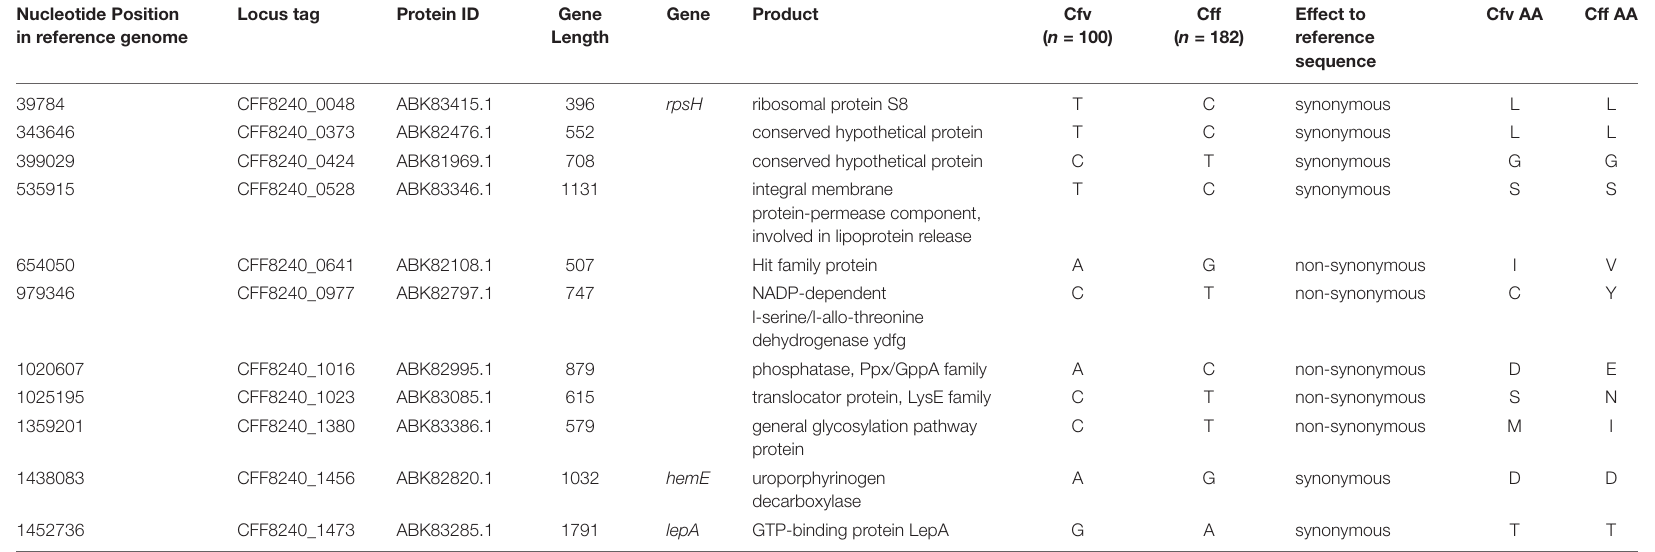
TABLE 2 | Eleven characteristic nucleotide markers for clade I in comparison to other clades. Nucleotide Position in reference